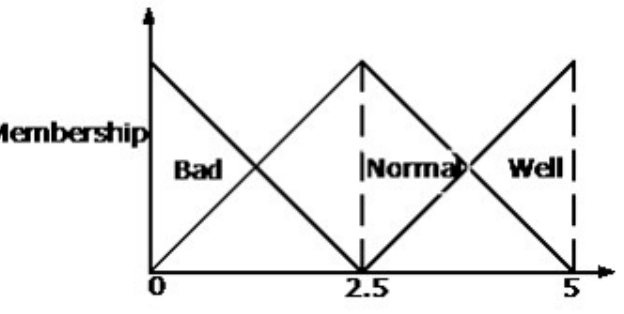
Figure 2. Membership function of bottom